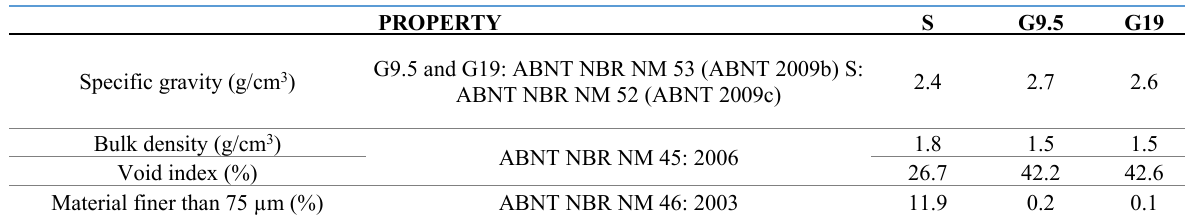
Table 2. Physical characteristics of the